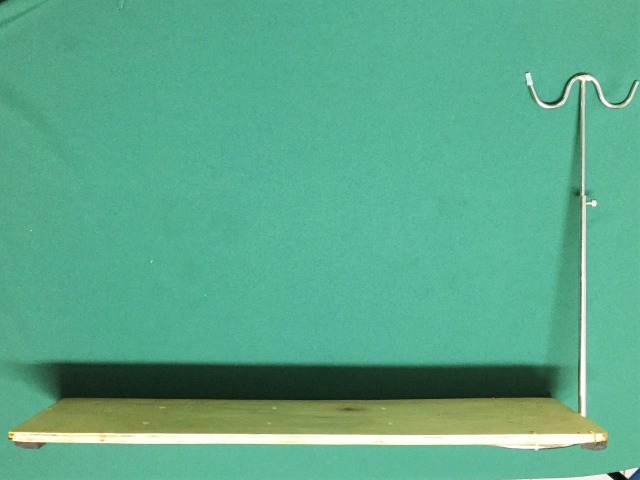
Base prepared and metal stand fixed to board.